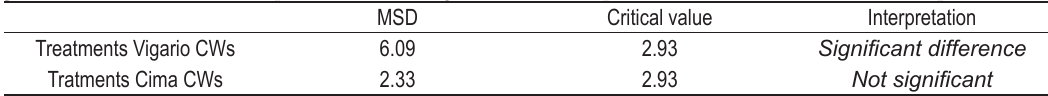
Table 4. Results obtained with Dunn´s test for evaluate the significant differences of treatments (with Typha domin- gensis Pers and without macrophyte) for Lake Vigário CWs (eutrophic) and Lake Cima CWs (mesotrophic).